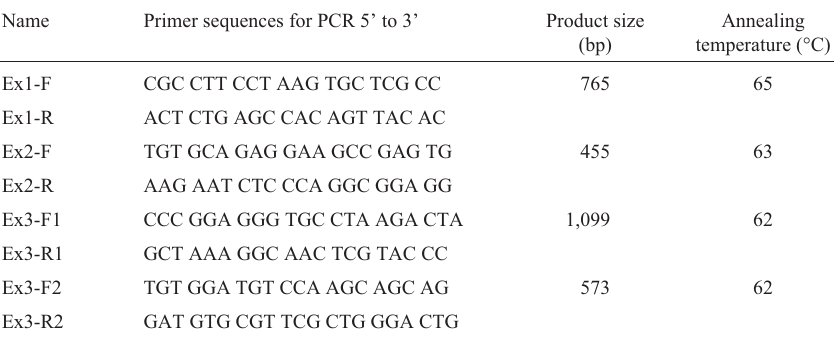
Figure 1 - The patient has short bowed legs with bilateral pretibial skin dimpling. Table 1 - Oligonucleotides and PCR conditions for SOX9 mutation